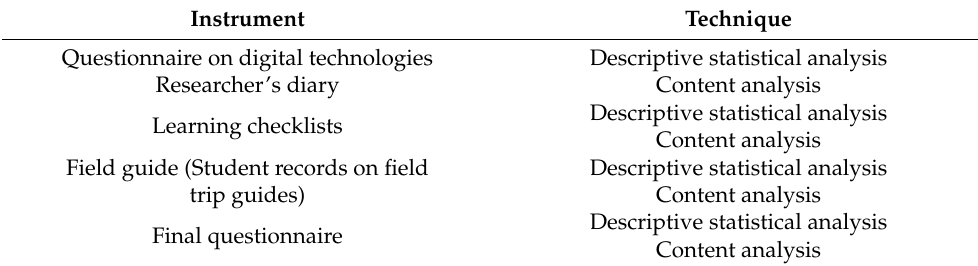
Table 2. Instruments and techniques for collecting and analyzing